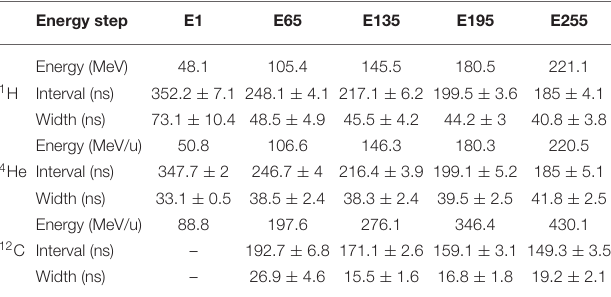
TABLE 1 | Bunch width and peak interval for proton, helium, and carbon beams for five energy steps ranging from 48.1 to 221.1 MeV/u, from 50.6 to 220.5 MeV/u, and from 88.8 to 430.1 MeV/u,